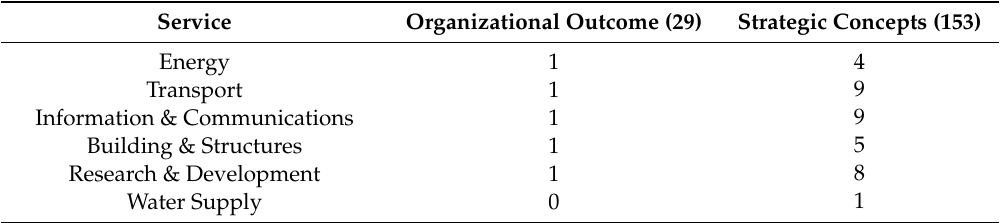
Table 8. The number of Organizational Outcomes and Strategic Concepts assigned to services in TSDFII. The total number of each are in